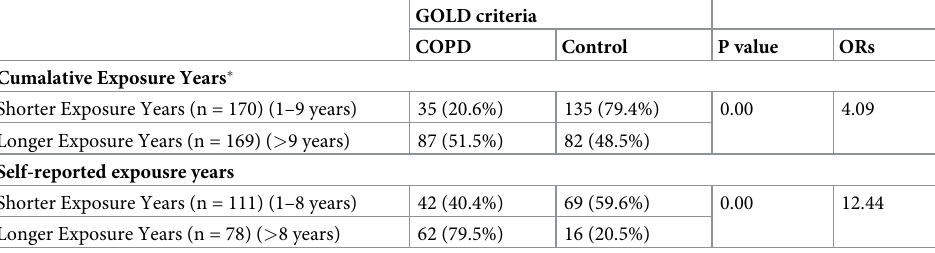
Table 4. Influence of longer and shorter occupational exposure years (both cumulative and self-reported) on COPD.